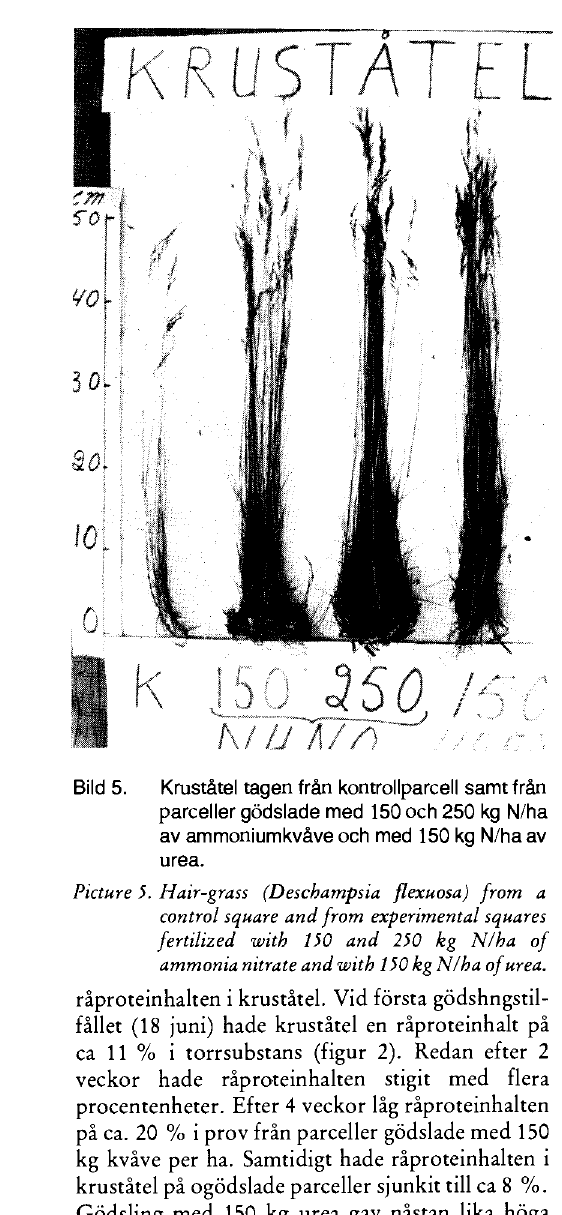
Picture 5. Hair-grass (Deschampsia flexuosa) from a Control square and from experimental squares fertilized with 150 and 250 kg N/ha of ammonia nitrate and with 150 kg N/ha of